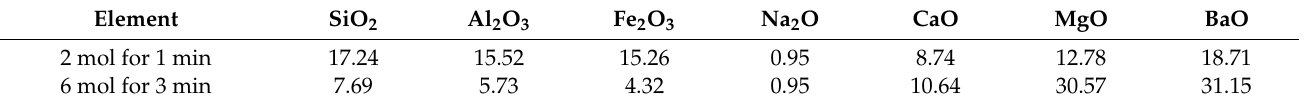
Table 3. Chemical component of acid leaching residues (wt%).